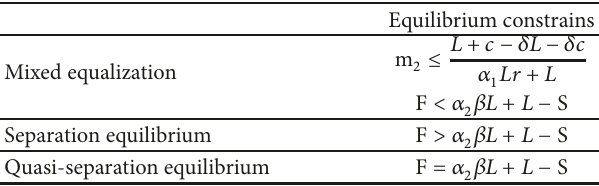
Table 3: Equilibrium constrains.